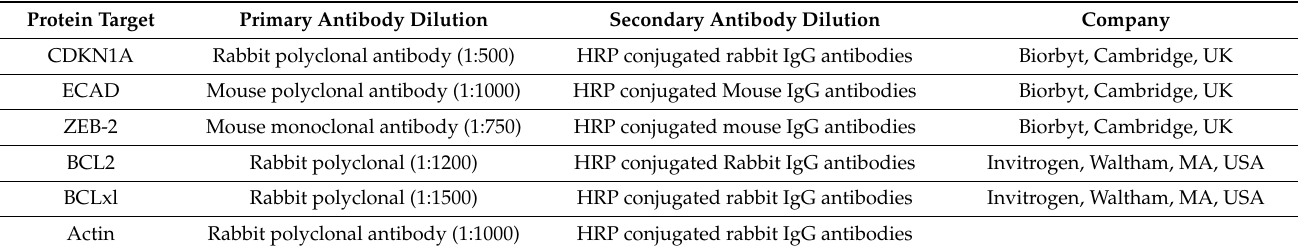
Table 3. List of used